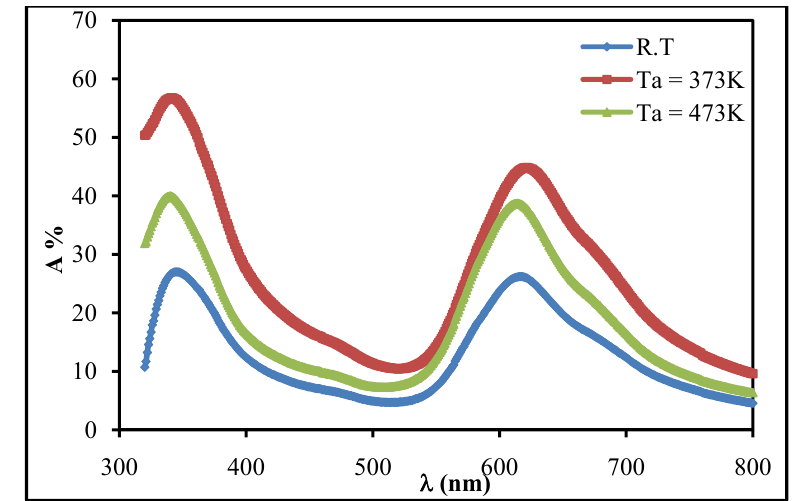
Fig. 2: Absorption spectrum of as-deposited and annealed NiPcTs thin films.